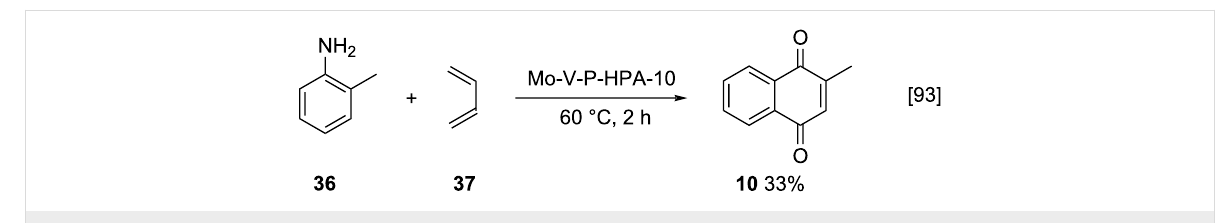
Scheme 9: o -Toluidine as a dienophile in a Diels–Alder reaction for the synthesis of menadione ( 10 ).